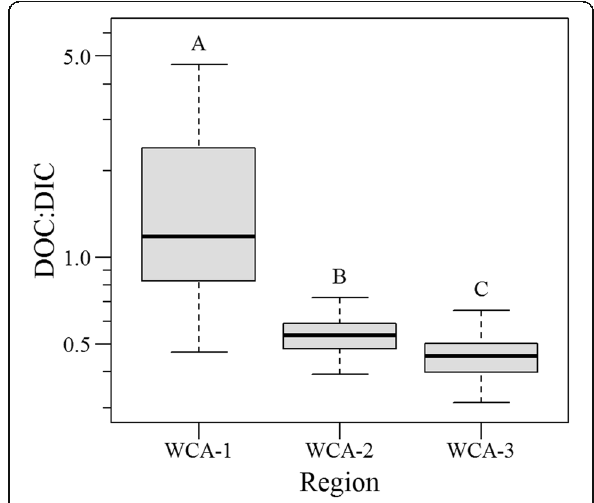
Fig. 5 Boxplot of dissolved organic carbon and dissolved inorganic carbon annual mean concentration ratio for each region of the Everglades Protection Area. Graphical representation of this data can be found in